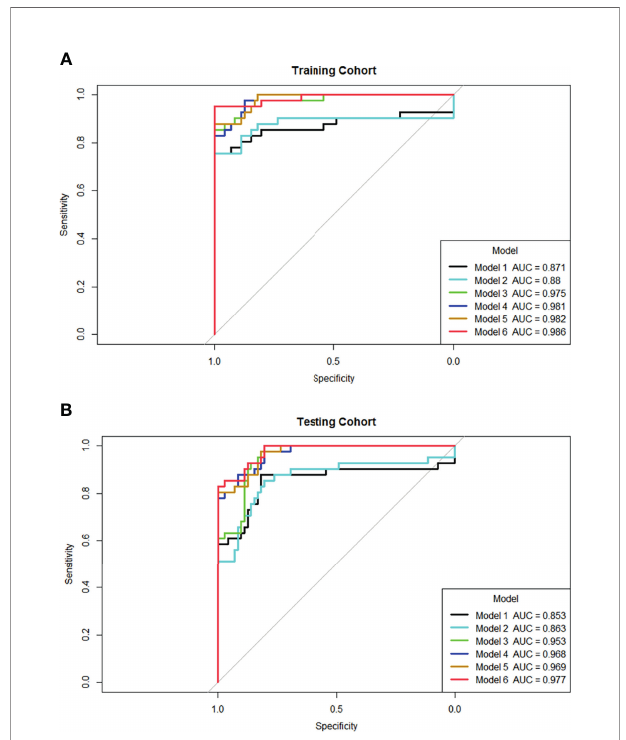
FIGURE 5 | ROC curves for six models ’ performance to distinguish csPCa in the training (A) and testing cohort (B) , respectively. Model 1: PI-RADS with bpMRI model; Model 2: PI-RADS with mpMRI model; Model 3: bpMRI-based radiomics model; Model 4: mpMRI-based radiomics model; Model 5: Combined PI-RADS and radiomics model with bpMRI; Model 6: Combined PI-RADS and radiomics model with